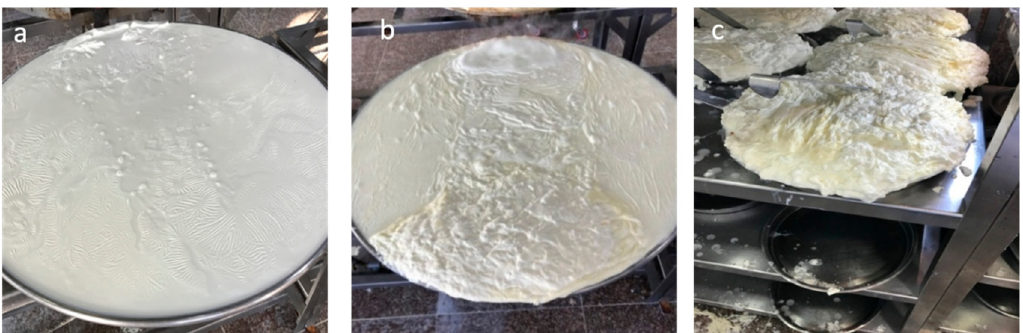
Figure 1. Key steps of Qishta process as observed at Hallab 1881 s.a.l. (Limited Anonymous Society).